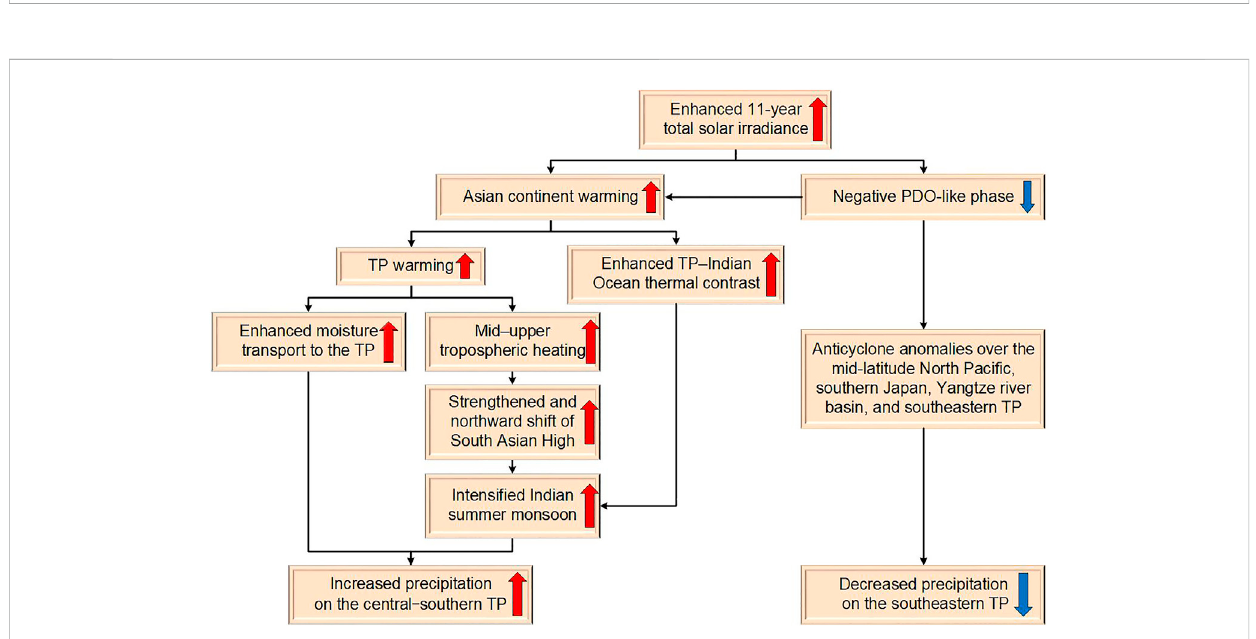
FIGURE 8 Schematic diagram of the mechanism responsible for the change in TP precipitation under the 11-year solar cycle.